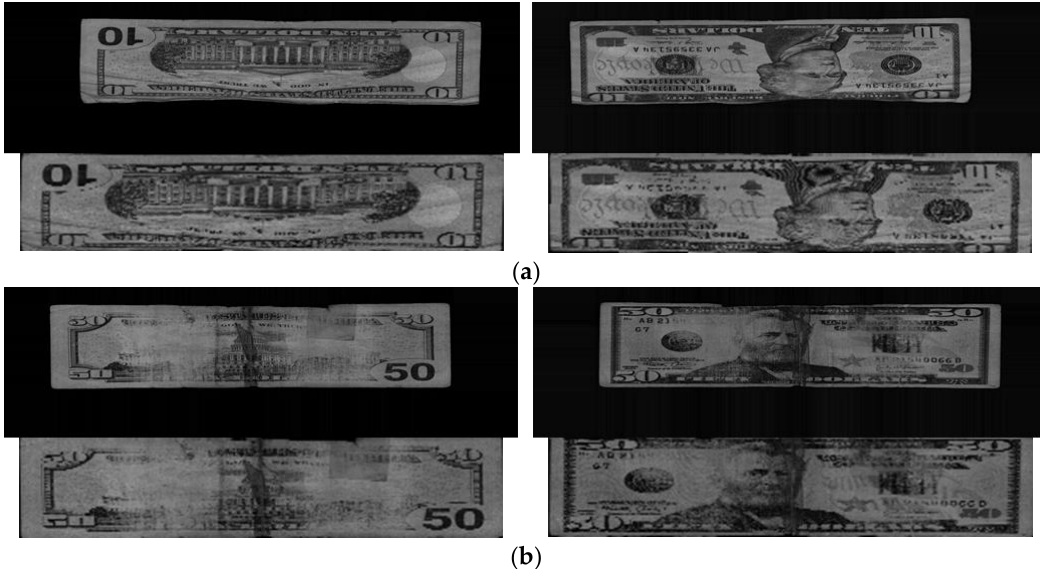
Figure 10. Classification error cases of the testing results when using previous method [5]: ( a ) Case 1; ( b ) Case 2.